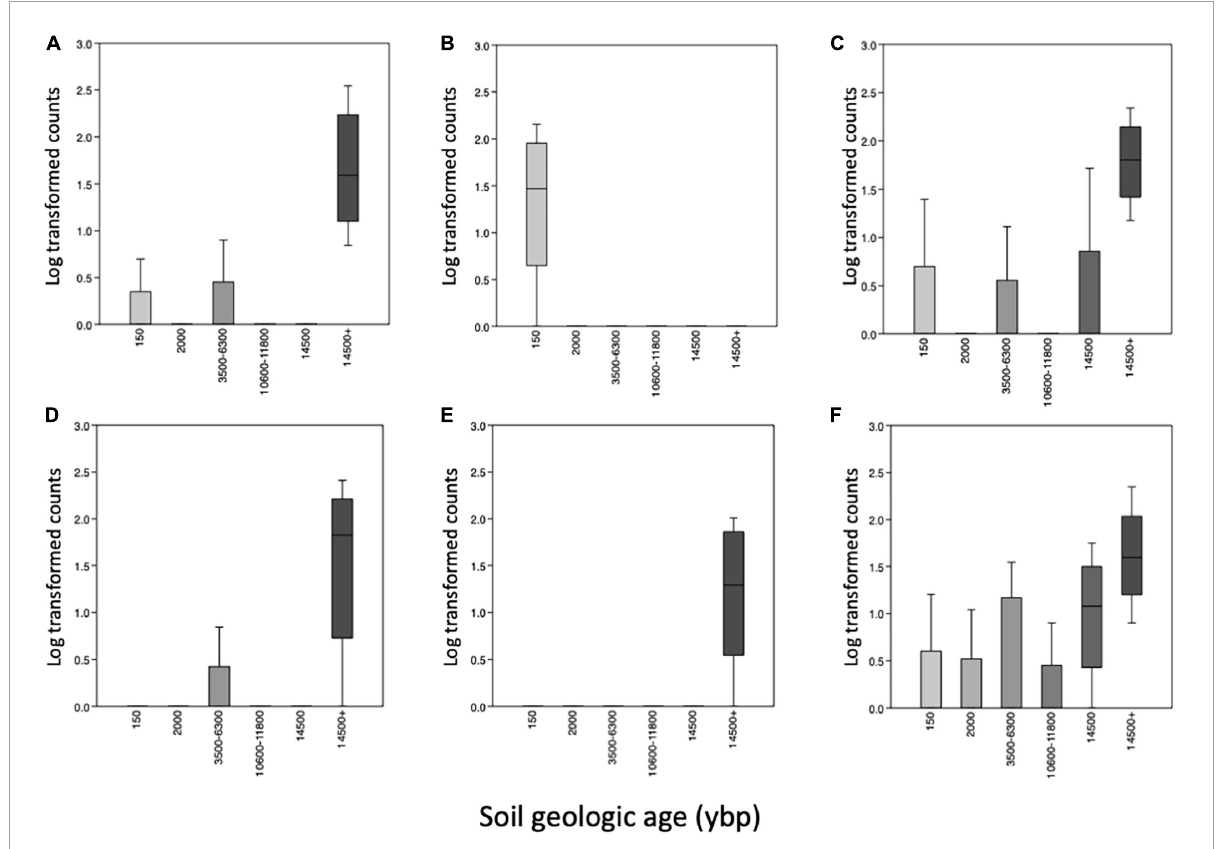
FIGURE5 Boxplot of medians and SD (standard deviations) of differentially abundant taxa identified using Analysis of Composition of Microbiomes (ANCOM) of microbial communities comparing the various soil geologic ages (ybp, years before present) along the y -axis. Taxa with W -values > 439 and clr > 34, (A) an uncultured Bacteriovoraceae (p__Bdellovibrionota), (B) Promicromonospora (p_Actinobacteriota), (C) Comamona s (p_Proteobacteria), (D) Geobacter (p Desulfobacterota), (E) an unnamed Latescibacterota and (F) Aurantisolimonas (p_Bacteoidota). W is number of time null hypothesis that were rejected and clr is the center log